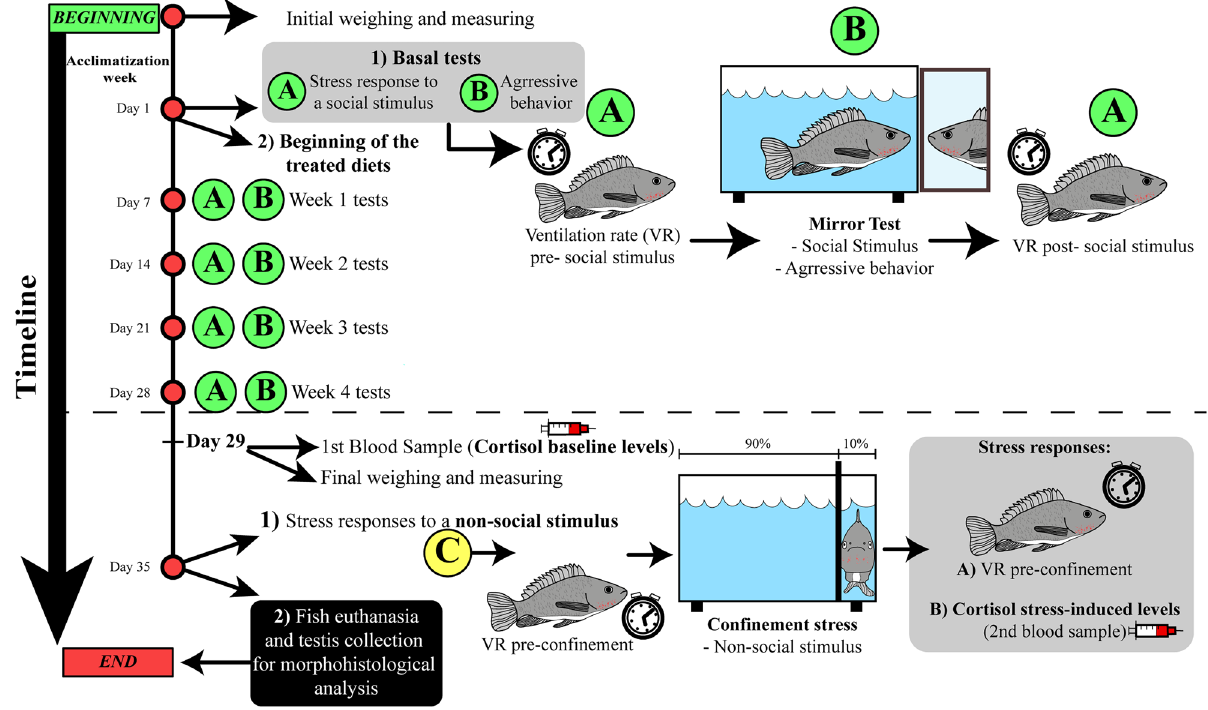
Figure 1. Experimental timeline and design—sequence of events during all the experiment (n = 15/group). The procedures start with fish acclimatizing to the isolated aquarium for 7 days (Acclimatization Week). Followed this step, firstly, on Day 1, basal fish’s aggressiveness level (represented in the figure by the green “A” letter) and stress response (Ventilation rate [VR]) to a social stimulus (represented in the figure by the green “B” letter”) were accessed through the mirror test. Afterward, fish started to receive the treated diets containing different cannabidiol (CBD) doses—0 (control), 1 (CBD 1), 10 (CBD 10) and 20 mg/kg (CBD 20). During the first four experimental weeks (Day 1 to Day 28), the aggressive behavior and the stress responses to a social stimulus were accessed once a week. In the fifth experimental week, some stress responses to a non-social stimulus (confinement stress) were measured (represented in the figure by the yellow “C” letter): on Day 29, blood samples were collected to analyze fish’s cortisol baseline levels; and on Day 35, confinement stress was applied to fish, and the VR and cortisol stress-induced levels were collected. Lastly, fish were euthanized (1500 µl/l of clove oil), and their testis were collected for morpho-histological analysis (gonads’ size and the number of